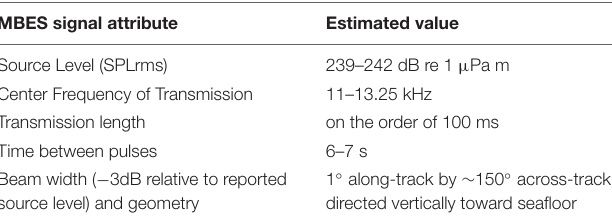
TABLE 1 | MBES signal attributes and the estimated value for the 2017 and 2019 MBES